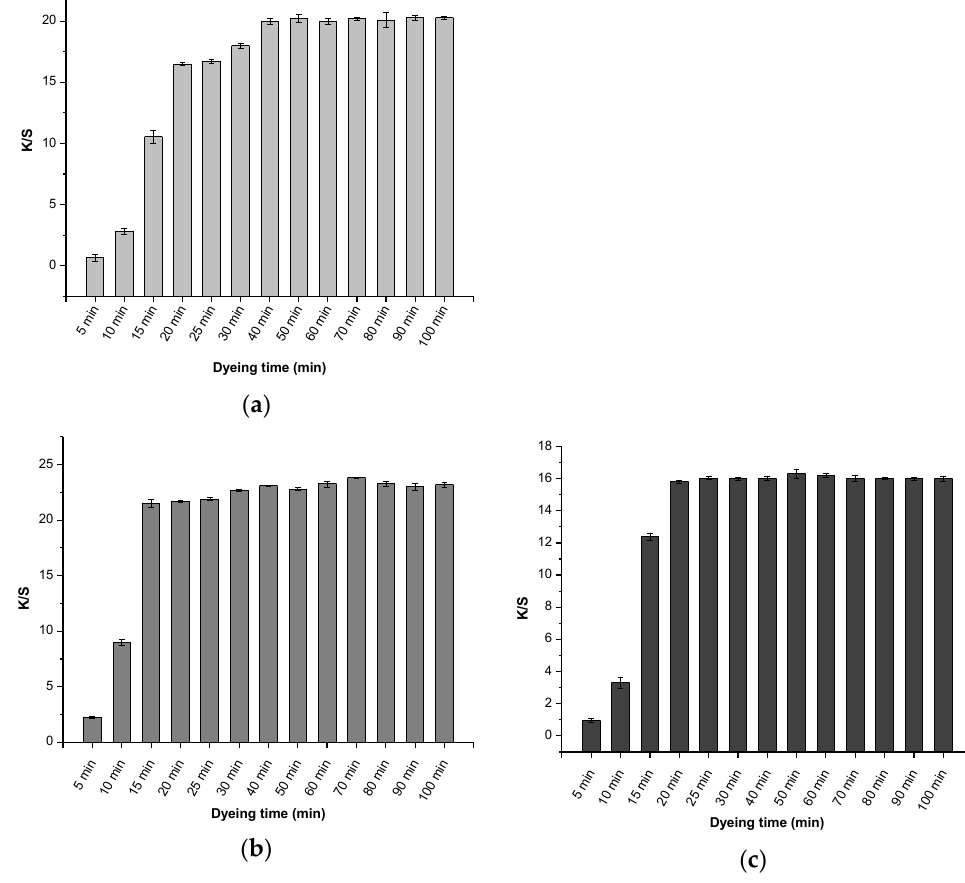
Figure 9. Effect of dyeing time on the color yield (K/S) of bicomponent filaments dyed with: ( a ) Dye Figure 9. E ff ect of dyeing time on the color yield (K / S) of bicomponent filaments dyed with: ( a ) Dye #H; ( b ) Dye #M; ( c ) Dye #L (pH = 7, Temperature = 130 °C, Concentration of carrier = 0 g/L). #H; ( b ) Dye #M; ( c ) Dye #L (pH = 7, Temperature = 130 ◦ C, Concentration of carrier = 0 g /